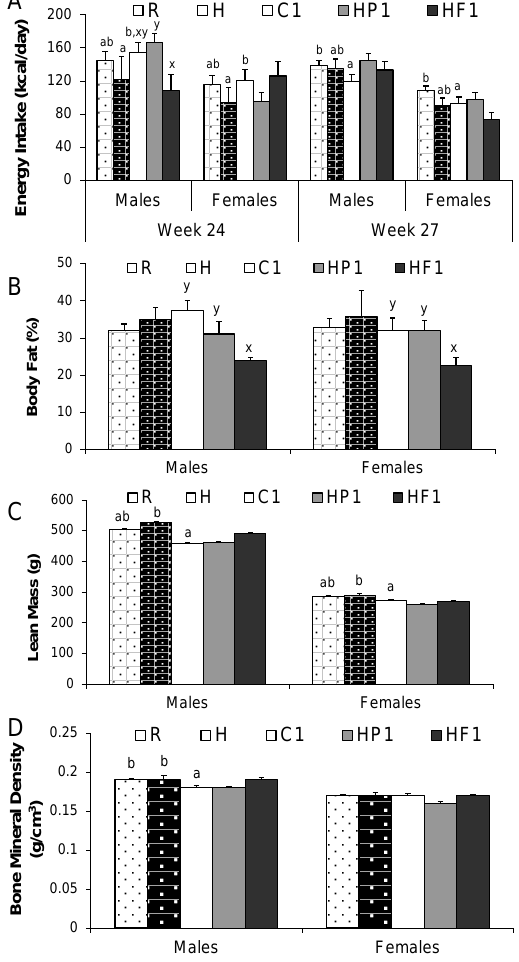
Figure 3. Energy intake ( A ), percent body fat ( B ), lean mass ( C ) and bone mineral density ( D ) at weeks 24 and 27 for all groups. Values are means ± SEM, n = 10 per group except n = 4 for group H. Treatments with different letters are significantly different between diets: superscripts x,y indicate significant difference between C1, HP1, HF1; superscripts a,b indicate significant difference between R, H and C1 ( p <